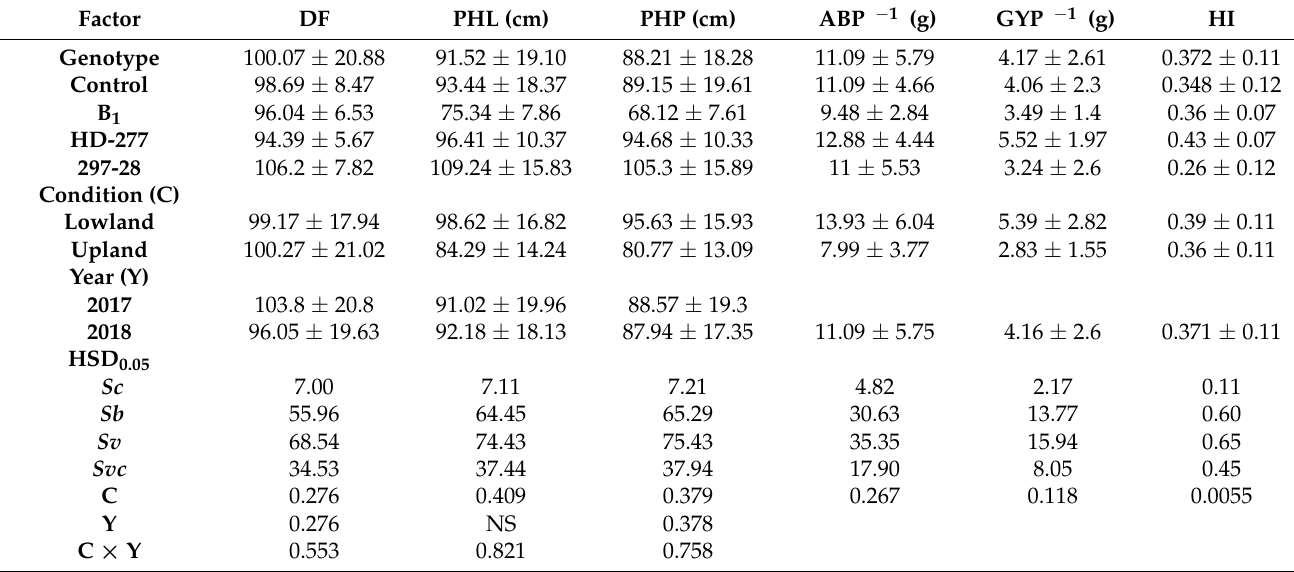
Table 4. Performance of measured six traits for genotypes and controls under lowland and upland conditions in 2017 and 2018 along with condition × year. Factor